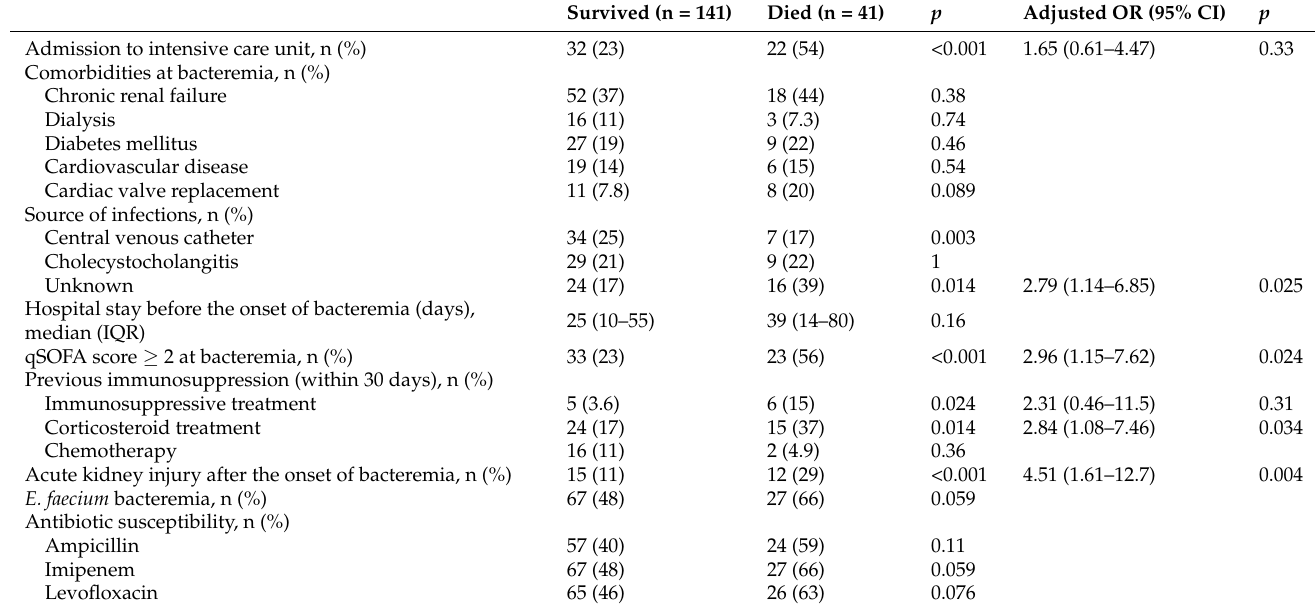
Table 4. Risk factors that were associated with 30-day mortality due to enterococcal